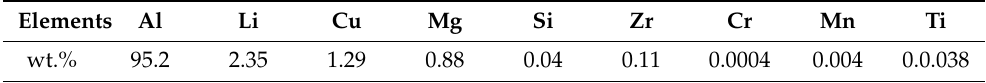
Table 2. Chemical composition of AA8090 aluminum alloy.